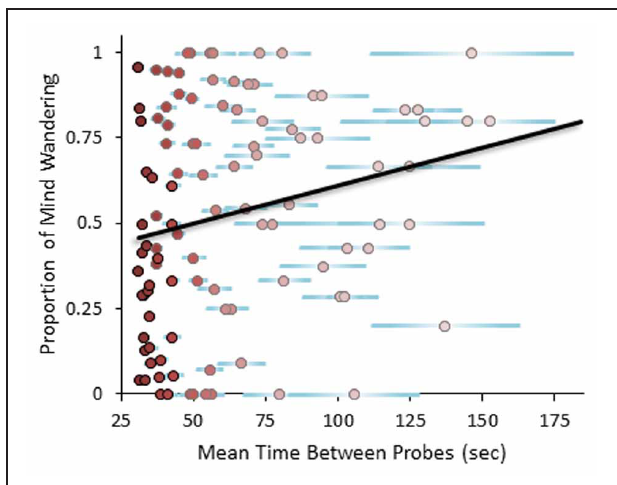
FIGURE 1 | Scatterplot showing linear relation of Mean Time Between Probes with proportionof self-reported mind wandering. Each point represents one participant, while the point color indicates the number of probes provided (darkest = 25, lightest = 5). Horizontal error bars show one standard error of the Mean Time Between